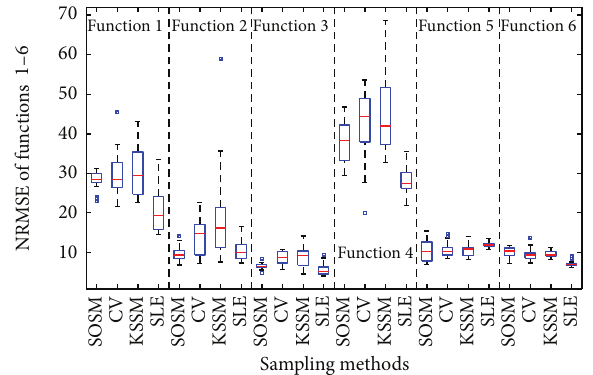
Figure 18: Assessment of metamodels: NRMSE between SOSM and previous sequential sampling